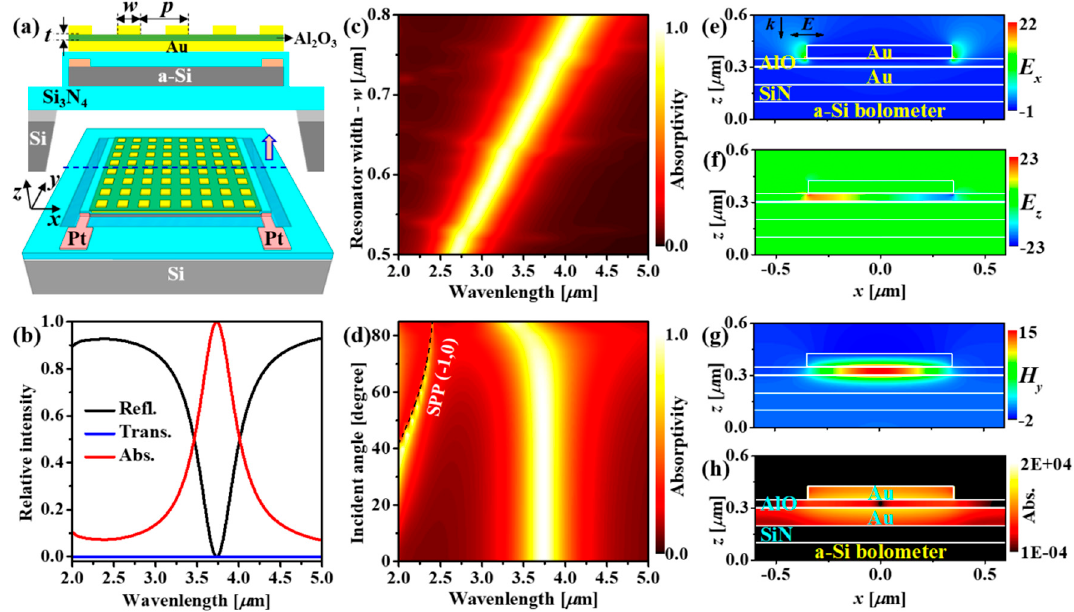
Figure 1. ( a ) Schematic illustrations, tilted view (bottom) and cross-sectional view (top), of the proposed MEMS-based wavelength-selective bolometer. ( b ) Simulated reflectance, transmittance and absorptivity of a device having geometrical parameters of p = 1.2 µ m, t = 0.045 µ m and w = 0.72 µ m exhibits a resonance at 3.73 µ m with a unity absorptivity. ( c ) Simulated absorptivity map of the chosen absorber for the proposed device show wide resonance tunability just simply by changing the size of the resonator while keeping other parameters unchanged ( p = 1.2 µ m, t = 0.045 µ m). ( d ) Simulated angle-dependent absorptivity of the absorber reveals a wide-range working angle up to 70 ◦ of the proposed devices. The peak appeared in the shorter wavelength region indicates SPP in periodic Au square array. ( e – h ) Simulated electric field ( E x , E z ), magnetic field– H y and absorption maps of a device excited at the resonance. In the simulations, the incident electric field propagated along the z -axis and oscillated along the x -axis. The thicknesses of the bottom Au layer and a-Si film were fixed at 0.1 µ m and 0.2 µ m for all simulations.